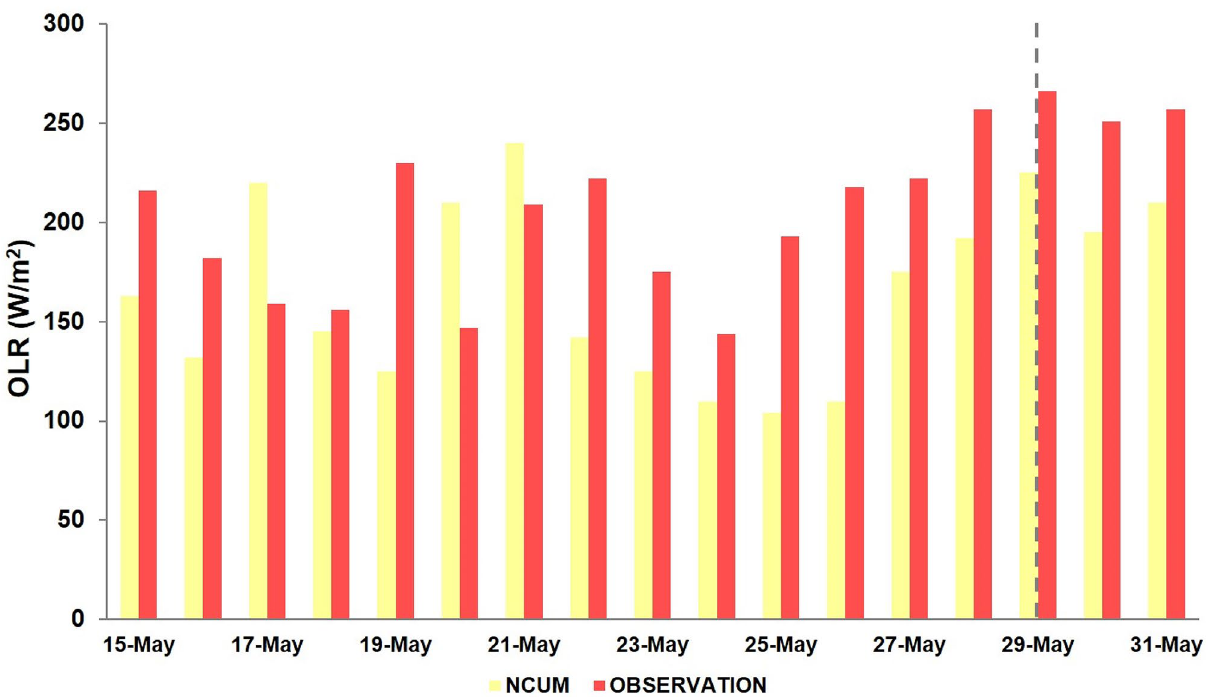
Fig. 4 Time series of NCUM 10-day forecasted outgoing long-wave radiation (OLR, W/m2) during 15–31 May 2018 along with INSAT-3D observations. The OLR is averaged over 5°–10° N and 70°–75° E. The vertical line indicates the IMD monsoon onset